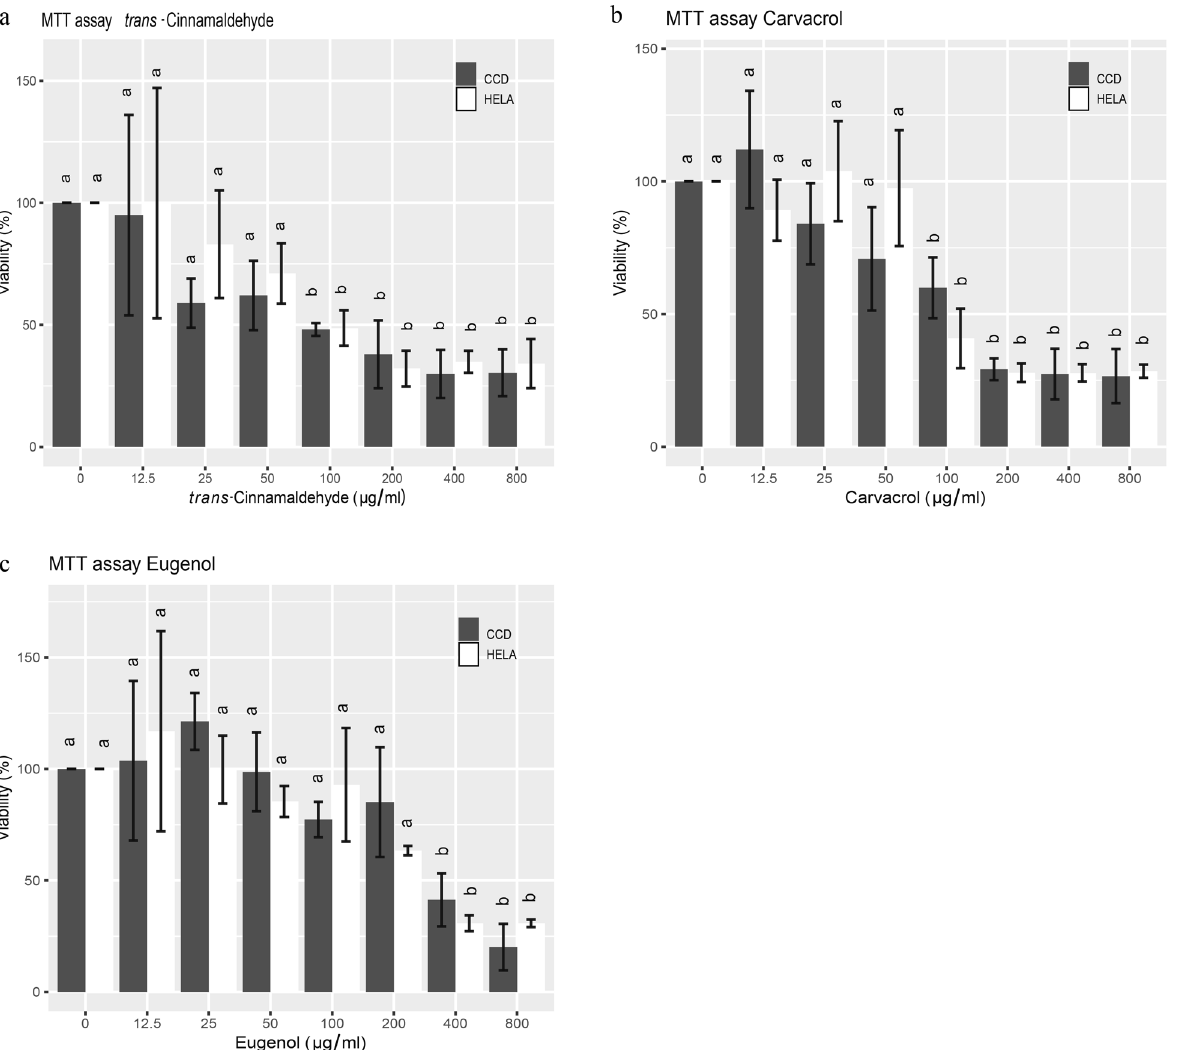
Figure 1. Effects of TCA ( a ), carvacrol ( b ) and eugenol ( c ) on the metabolic activity (MTT assay) of HeLa and CCD cells after 24 h of treatment. The metabolic activity of treated cells was expressed as percentages over controls without PDA treatments. Bars with different alphabet labels within cell types are significantly different ( P ≤